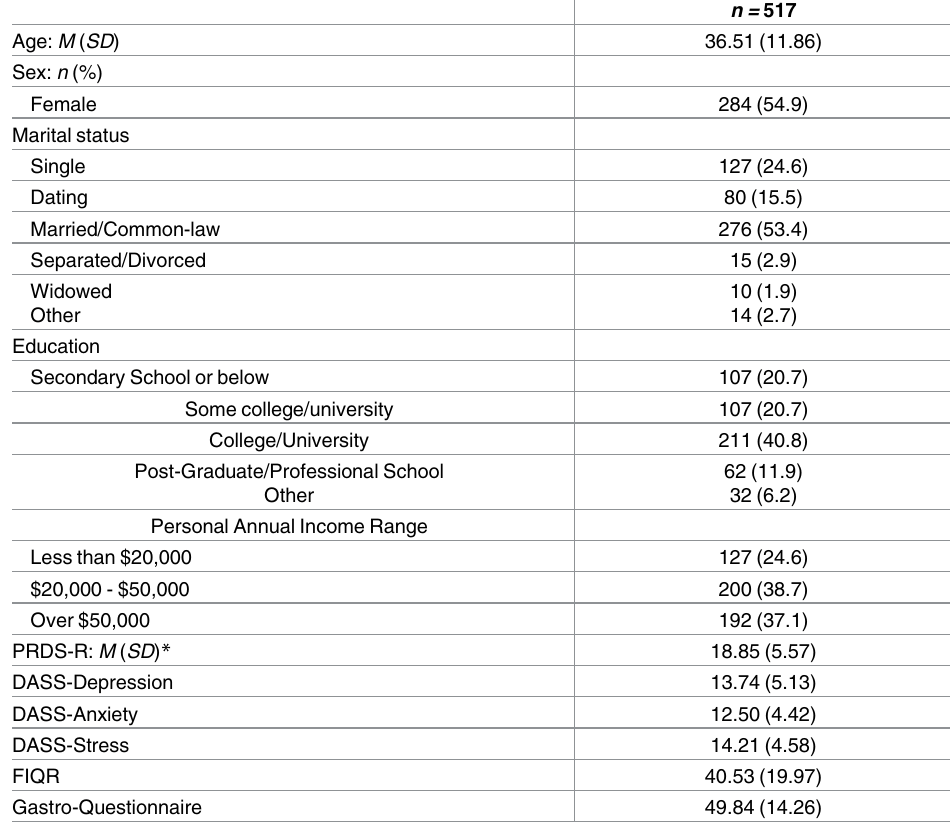
Table 1. Demographic